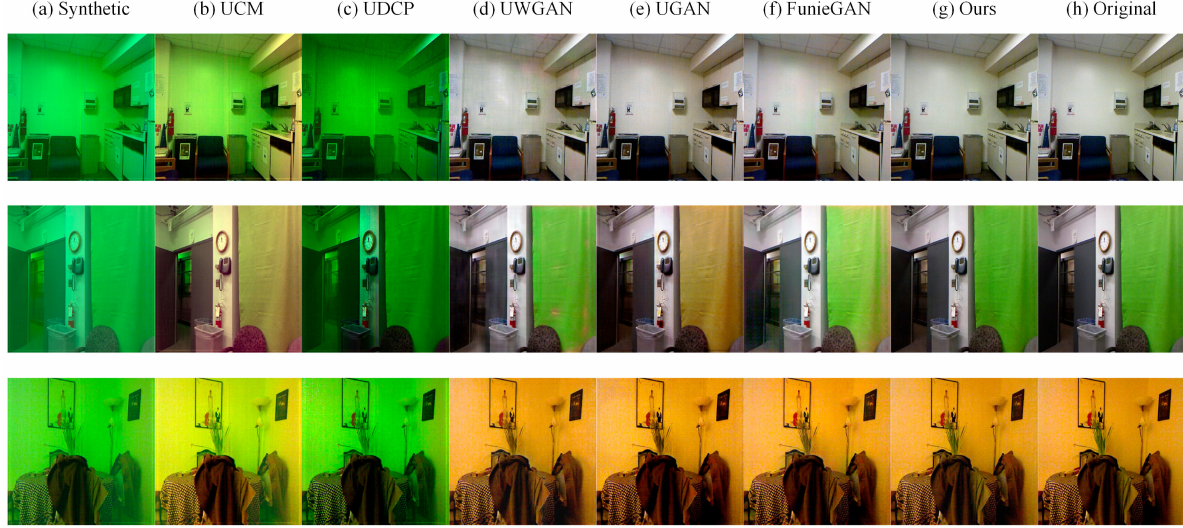
Figure 6. Qualitative comparisons for samples from synthetic underwater datasets. ( a ) Synthetic underwater degraded images. ( b ) Results of UCM. ( c ) Results of UDCP. ( d ) Results of Unet3. ( e ) Results of UGAN. ( f ) Results of FunieGAN. ( g ) Our results. ( h ) Ground truth.